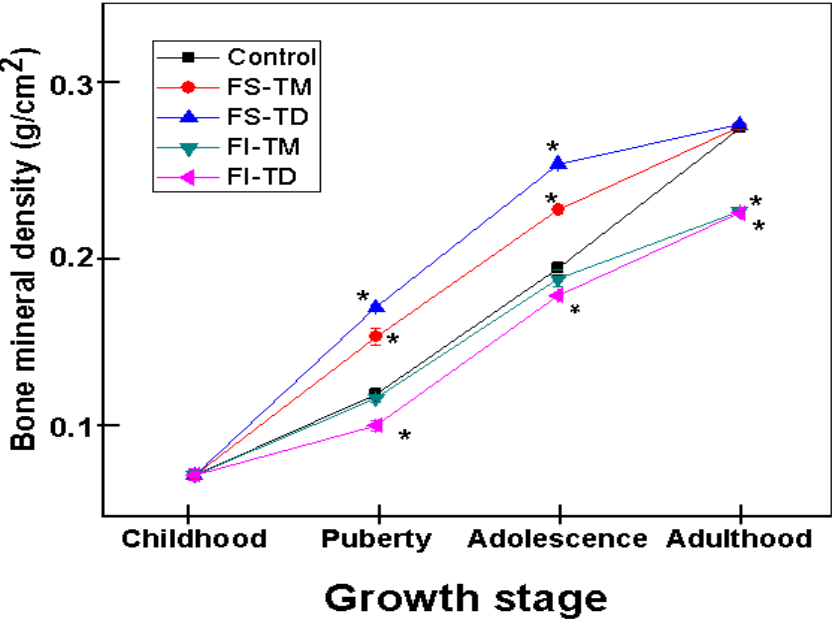
Figure 2. Bone mineral density (BMD) of the femurs of male Wistar growing rats fed with the soluble and insoluble fibers extracted from O. ficus indica cladodes at early and late maturity stages as the only dietary calcium source. The values represent mean ± SD n = 7. * Significantly different from the values of the bones from rats fed with the control diet at the same growing stage ( p ≤ 0.05).